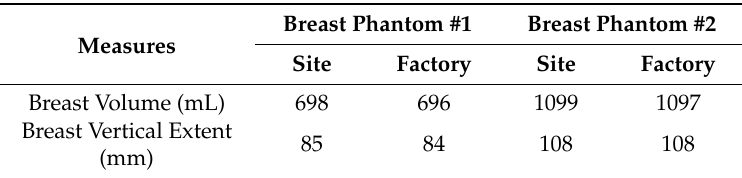
Table 1. Breast Phantom Metrology, Based on the Optical